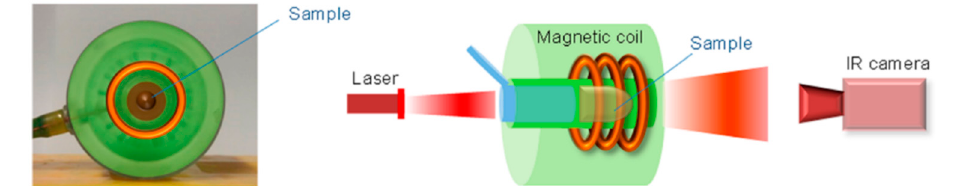
Figure 7. Scheme of the experimental device for combined hyperthermia experiments consisting of a magnetic coil in which the sample is placed, so that it can be illuminated by the NIR laser. The temperature increase was recorded with an infrared thermal image camera located at the end of the coil cavity. Reprinted with permission from ACS Nano 10, 2, 2436–2446. Copyright 2016. American Chemical Society [138].